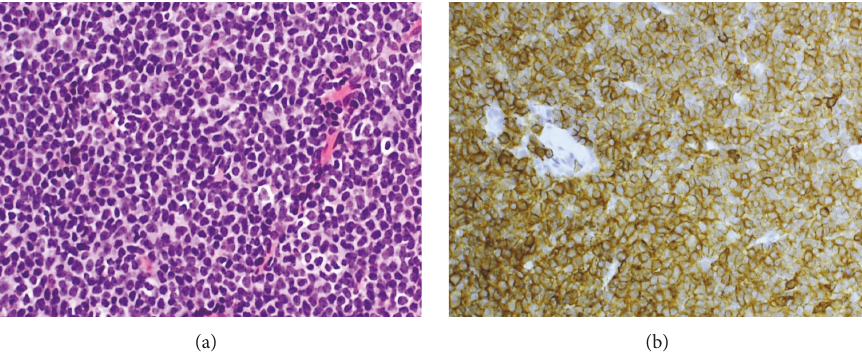
Figure 1: Axillary lymph node: (a) Haematoxylin and eosin stain showing monomorphic proliferation of small lymphocytes in keeping with CLL. (b) Immunoperoxidase stain showing positive staining of lymphocytes for CD5.